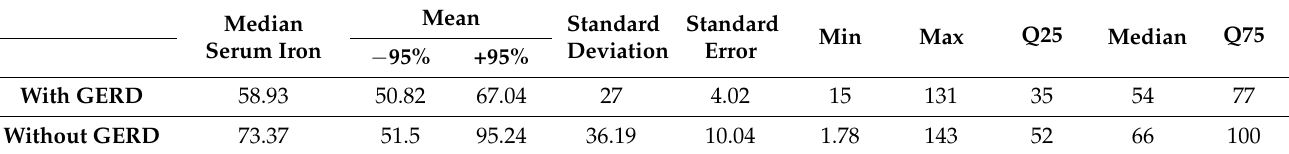
Table 7. Statistical indicators for serum iron in relation to GERD.